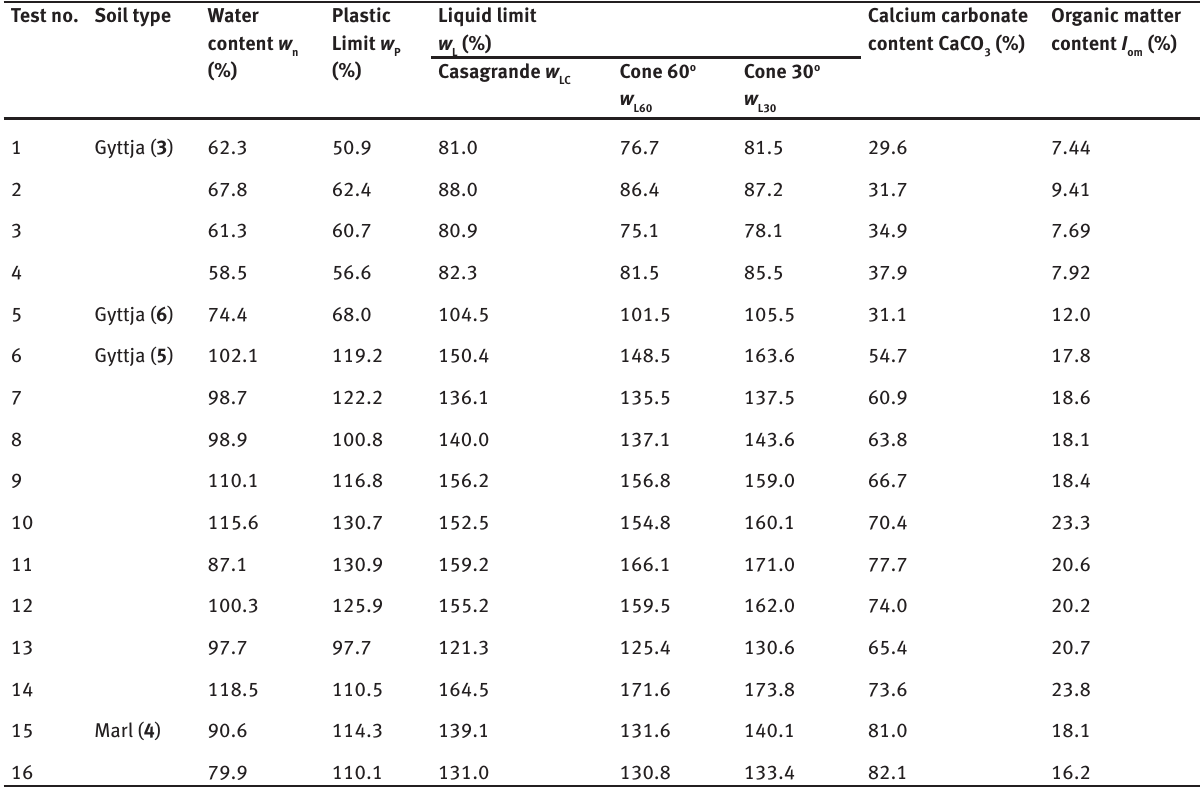
Table 3: Laboratory test results of the index properties of Eemian gyttja. Test no. Soil